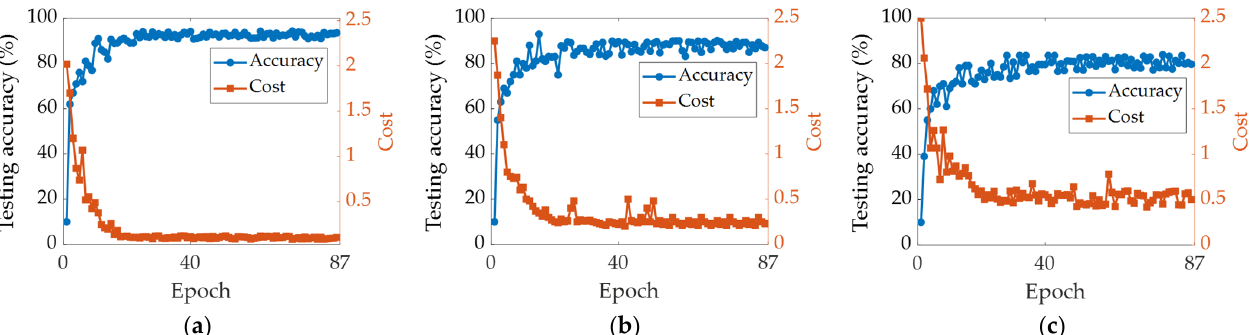
Figure 7. Learning curves of the ( a ) CNN, ( b ) DNN, and ( c ) MLP models for the “rough condition”, showing the testing accuracy and cost with respect to the number of epochs.